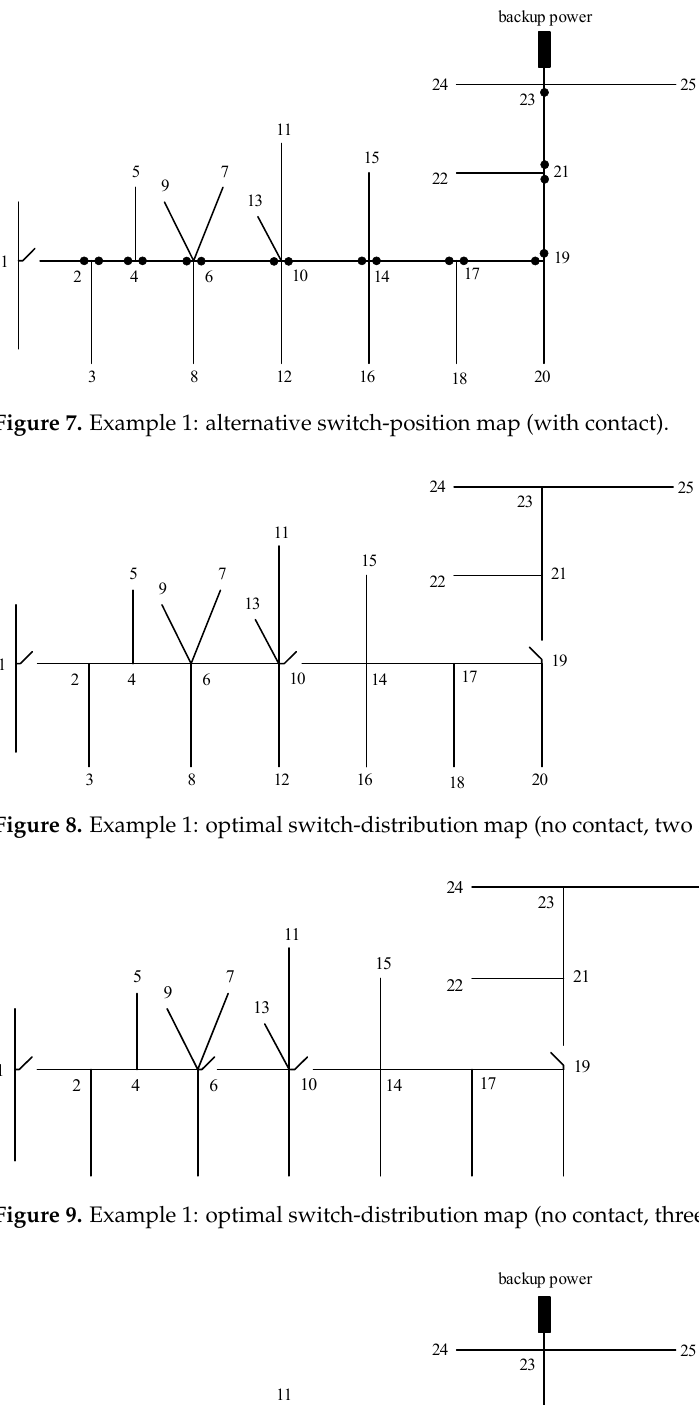
Figure 6. Example 1: alternative switch-position map (no contact).